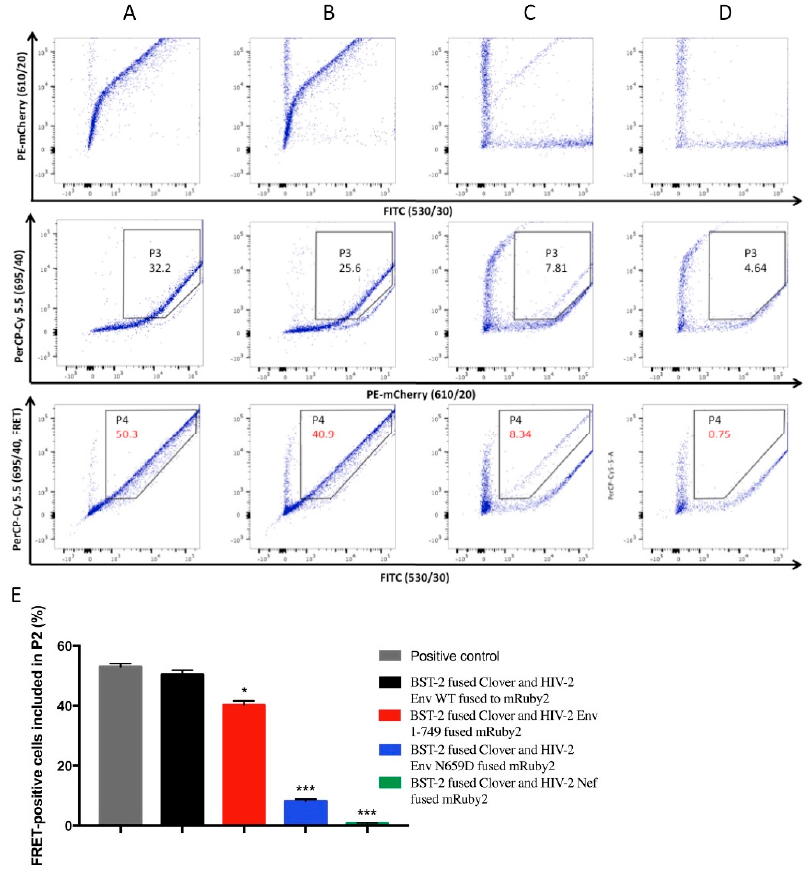
Figure 7. HEK293T cells co-expressing the fusion proteins in the following combinations were analyzed with the configured BD FACSAria™ III cell sorter. ( A ) BST-2 fused Clover and HIV-2 Env WT fused to mRuby2; ( B ) BST-2 fused Clover and HIV-2 Env 1–749 fused mRuby2; ( C ) BST-2 fused Clover and HIV-2 Env N659D fused mRuby2 and ( D ) BST-2 fused Clover and HIV-2 Nef fused mRuby2. Numbers indicated in gate P4 give the percentage of FRET-positive cells included in P2 according to the previous fluorescence-activated cell sorting (FACS) configuration for the different co-expression in living